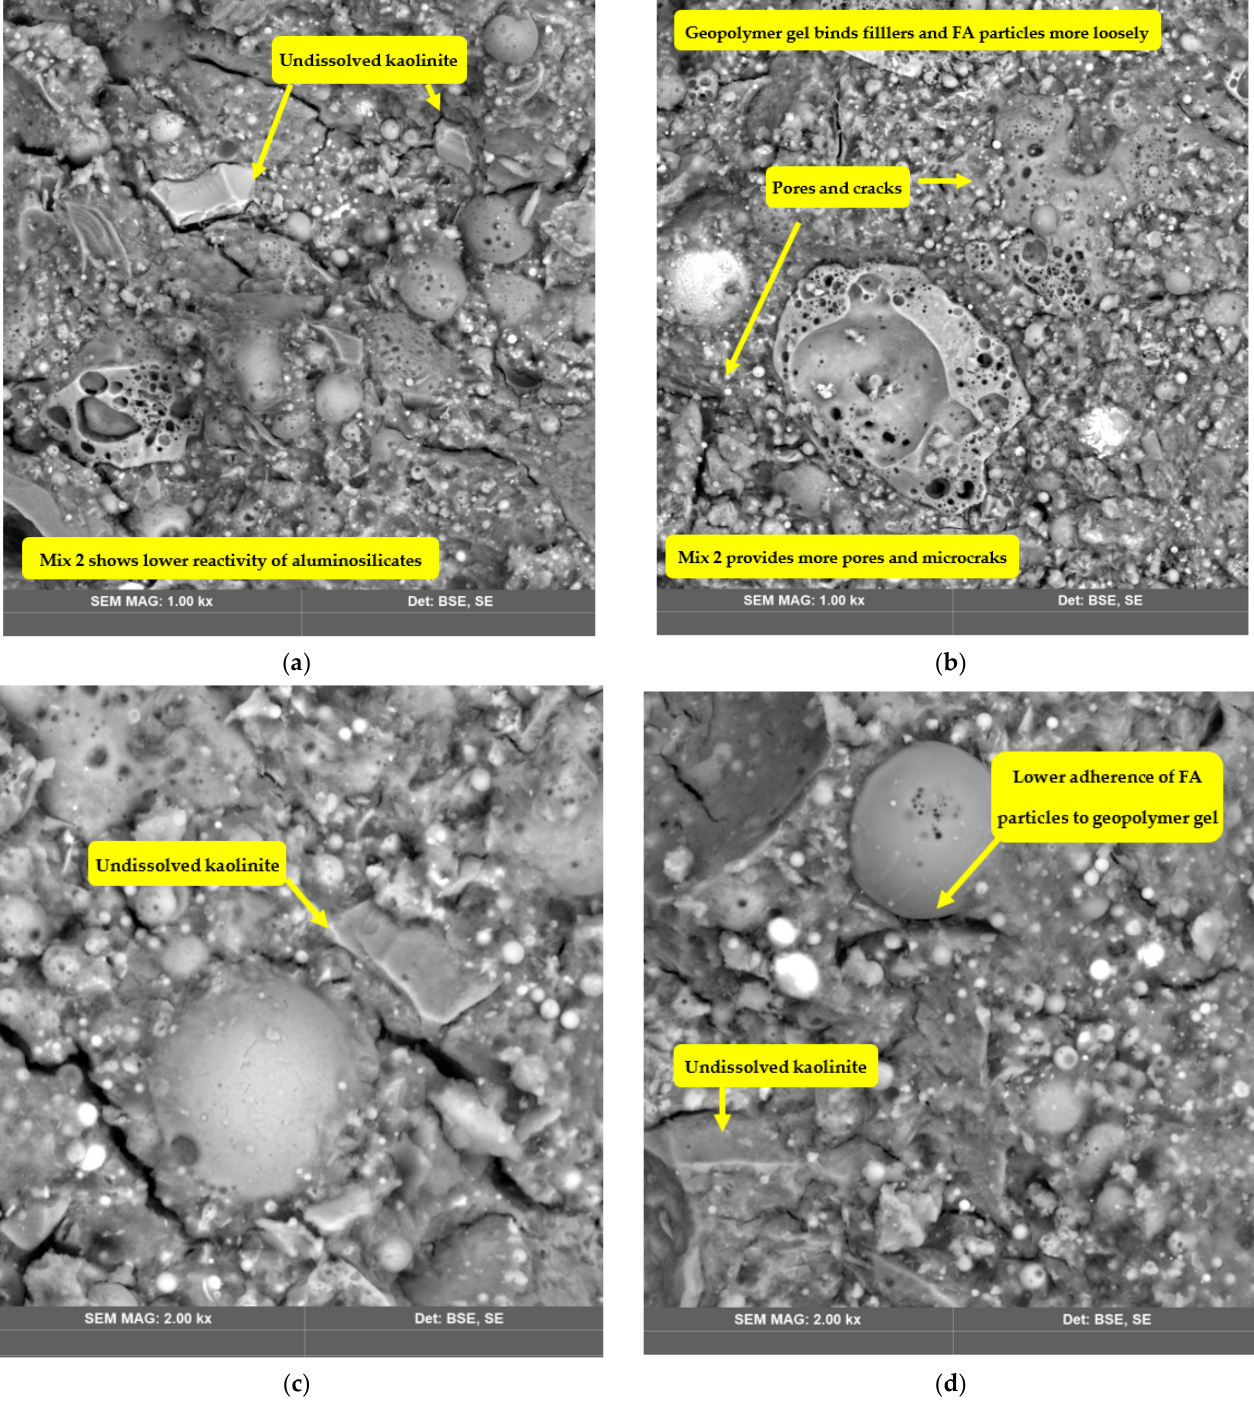
Figure 6. SEM images of Mix 2. The images on the left ( a , c ) were taken after 3 days of curing, and the images on the right ( b , d ) were taken after 28 days of curing.